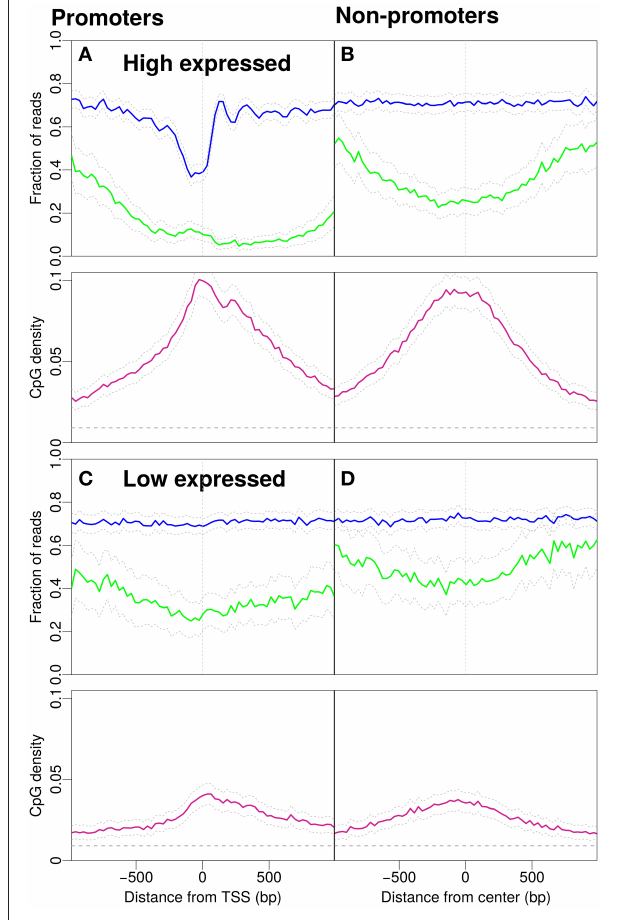
FIGURE 2 | Nucleosome occupancy (blue), methylation level (green) and CpG density (pink). (A) Promoters with high gene expression (900 promoters selected, see Materials and Methods). (B) Non-promoter regions with similar CpG density profiles as in (A) (898 regions selected, see Materials and Methods). Methylation drops around the midpoint of the region and the GpCs are, on average covered by nucleosomes. (C) Profiles for promoters with low gene expression (901 promoters selected, see Materials and Methods). (D) Non-promoter regions with similar density profiles as in (C) (900 regions selected, see Materials and Methods). The gray dashed line indicates the average CpG density (0.009) in the